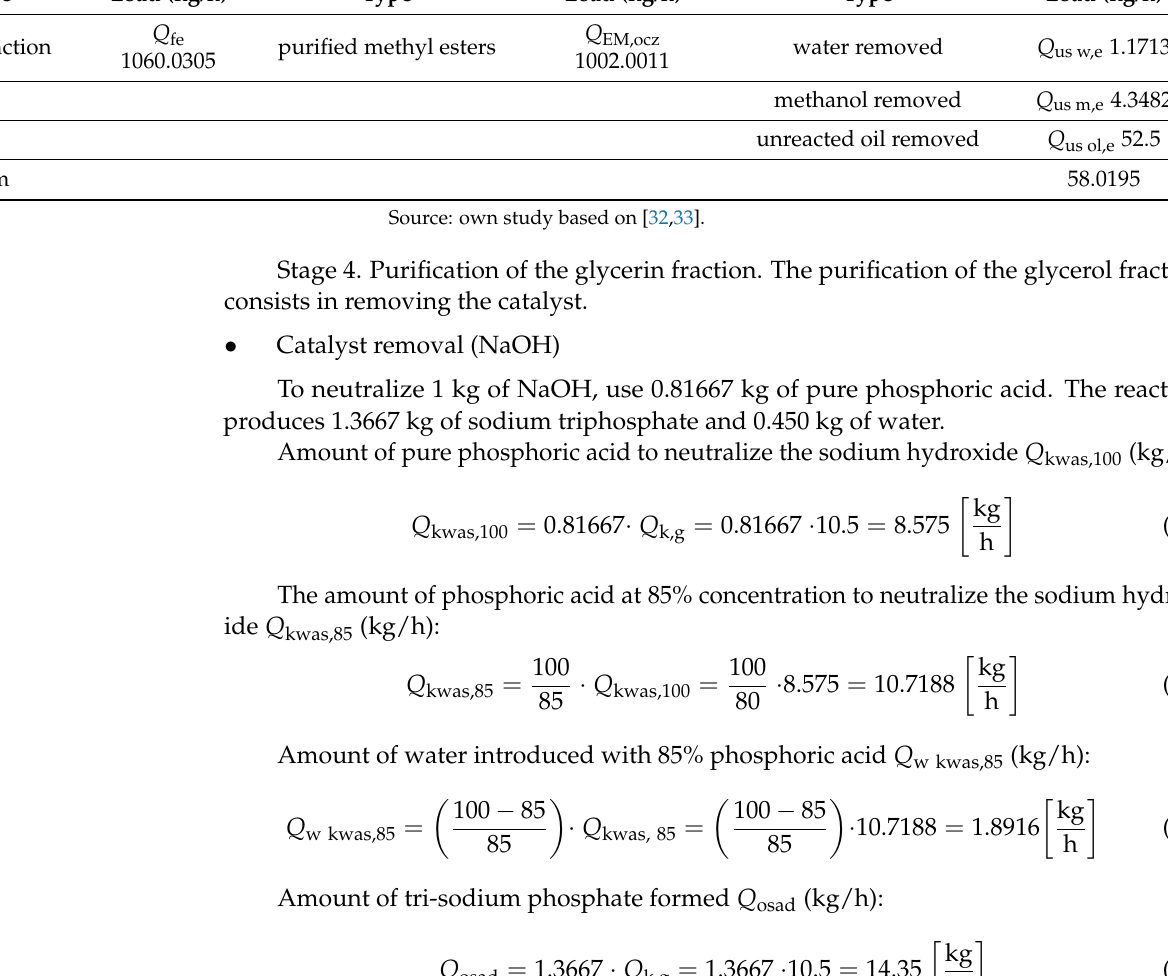
Table 6. Material balance of raw materials, products, and by-products after the methyl ester purification step.